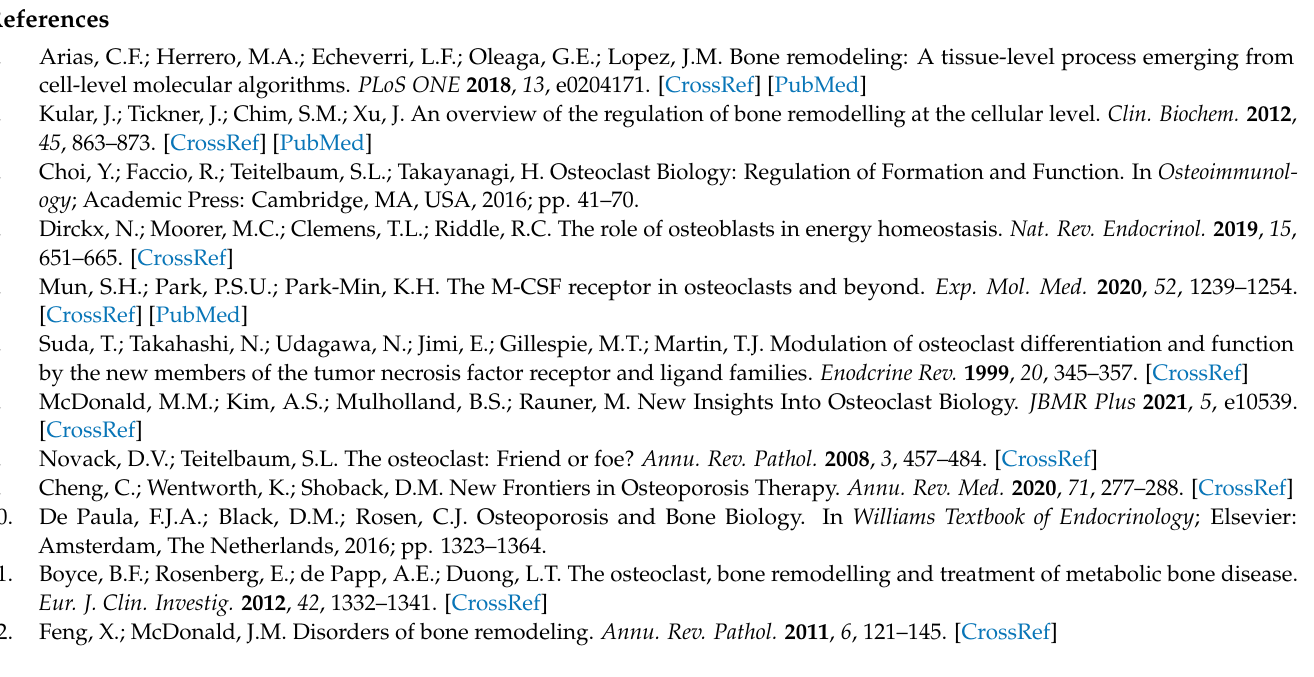
DEGs. Figure S1b: Cluster analysis of downregulated DEGs. Figure S2: Expression of monocyte marker genes in the OC and PBMC groups. Table S1: Differentially expressed genes identified between the OC and PBMC groups. Table S2: Top 10 enriched pathways identified in each GO annotation for the upregulated gene set. Table S3: Top 10 enriched pathways identified in each GO annotation for the downregulated gene set. Table S4: GSEA KEGG pathway analysis of up and downregulated DEGs. Table S5a: KEGG analysis of top 3 upregulated gene clusters identified by STRING. Table S5b: KEGG analysis of significant downregulated gene clusters identified by